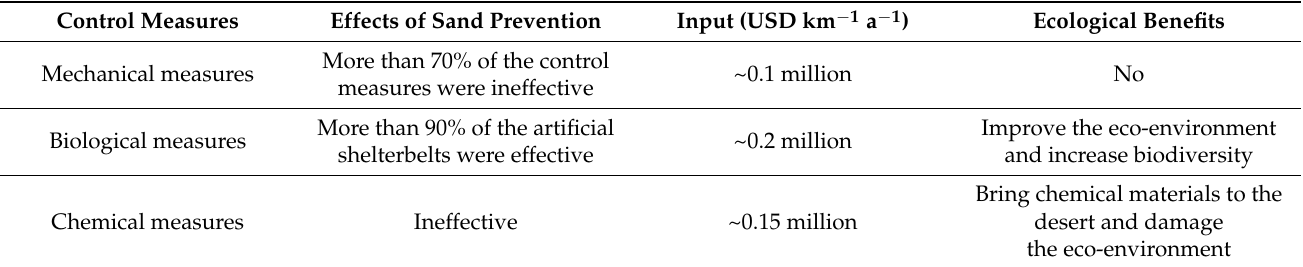
Table 1. Sand fixation efficiency and cost of the three sand-fixing measures